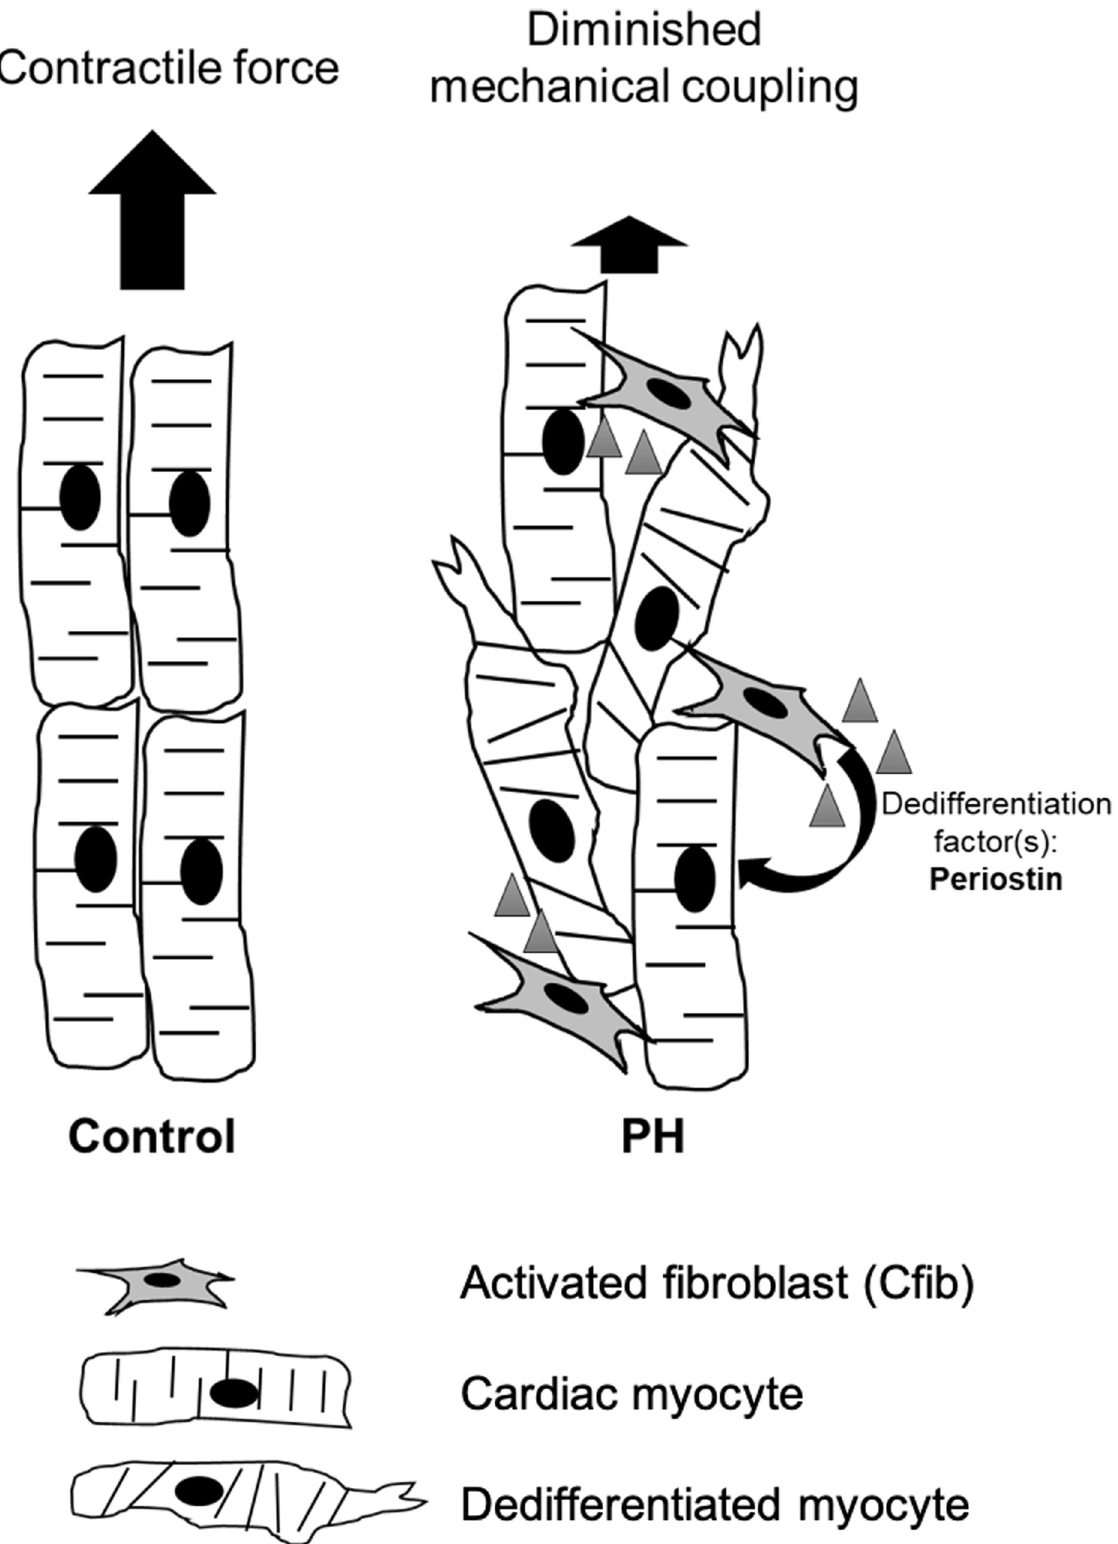
Fig 8. Working model of Cfib-mediated disruption of sarcomeric organization and loss of contractile function. Identification of additional secreted factor(s) which drive dedifferentiation and myocyte plasticity will improve therapeutic strategies.